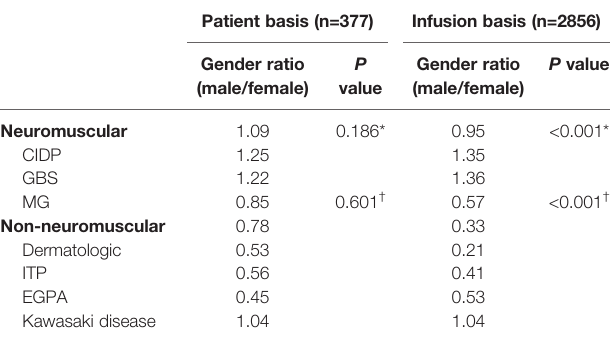
TABLE 2 | Patients demographics on gender in autoimmune diseases.